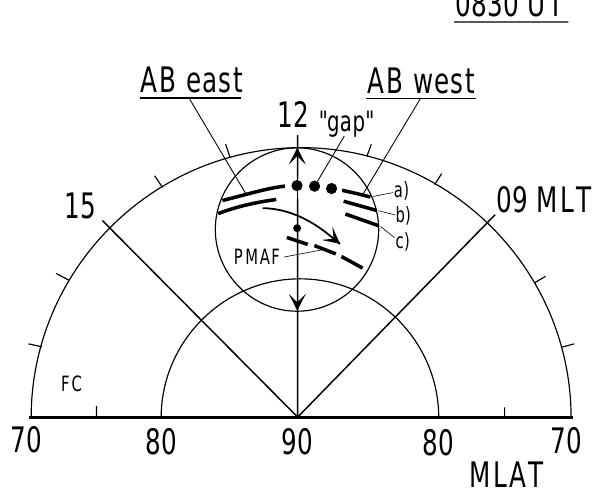
Fig. 19. Schematic illustration of the auroral brightening event dur- ing the interval 08:25–08:40 UT on 12 December 1999. The coor- dinate system is MLAT/MLT. Same format as in Fig.